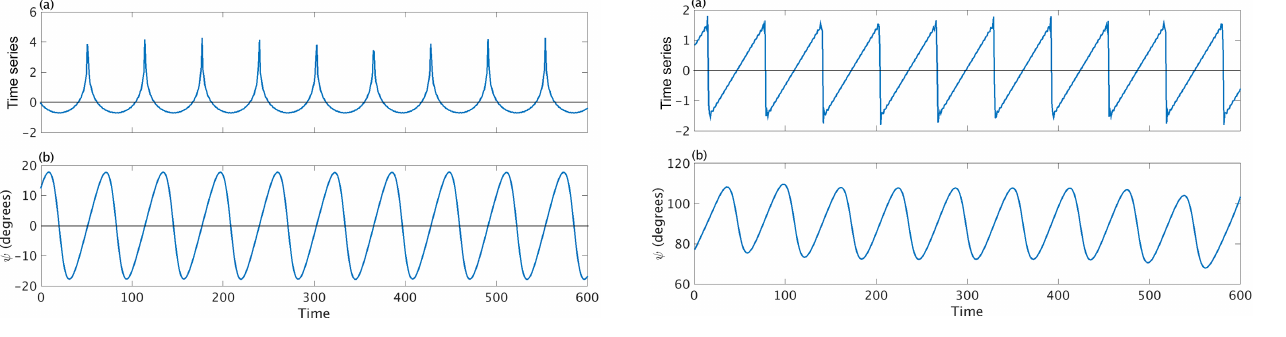
Figure 3. (a) A sawtoothed time series and (b) its corresponding local biphase. The biphase close to 90 ◦ indicates a nonlinear in- teraction resulting in an asymmetric waveform. The biphase was calculated from the first three cosines in the